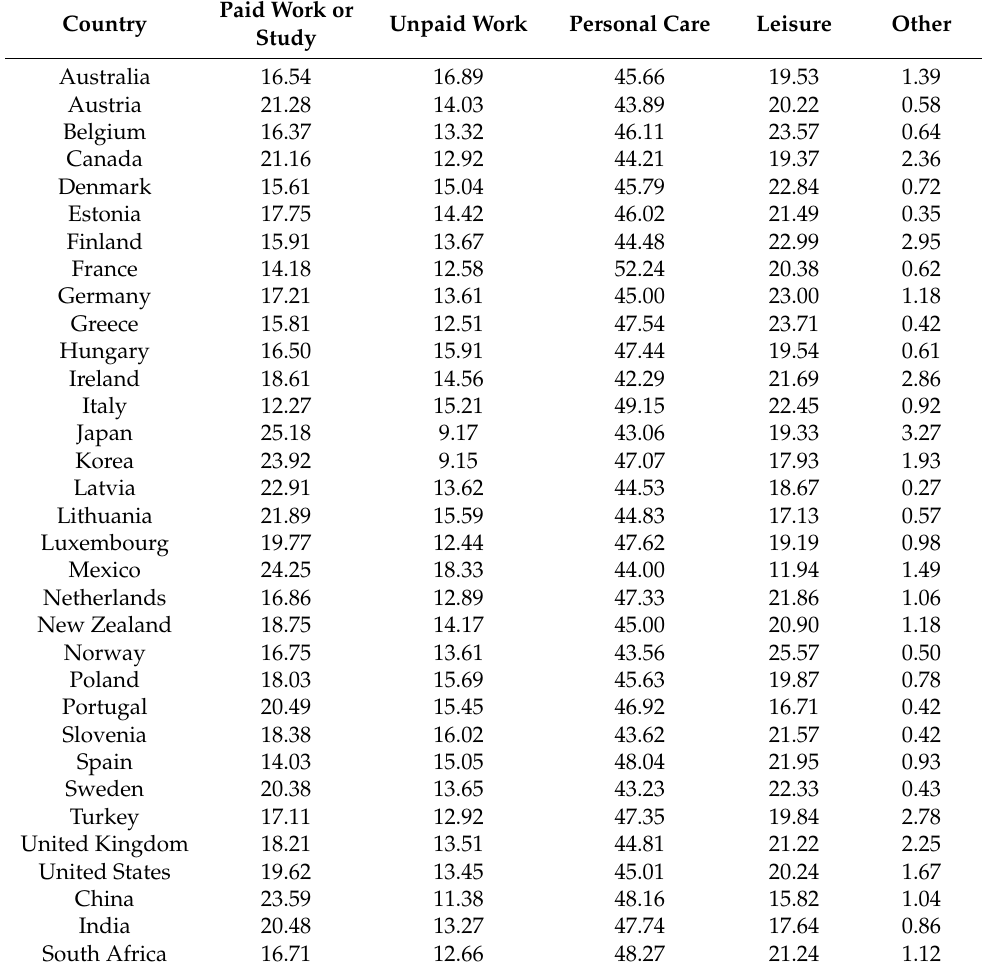
Table 1. Time use in percentages among the 15–64 age group (%).